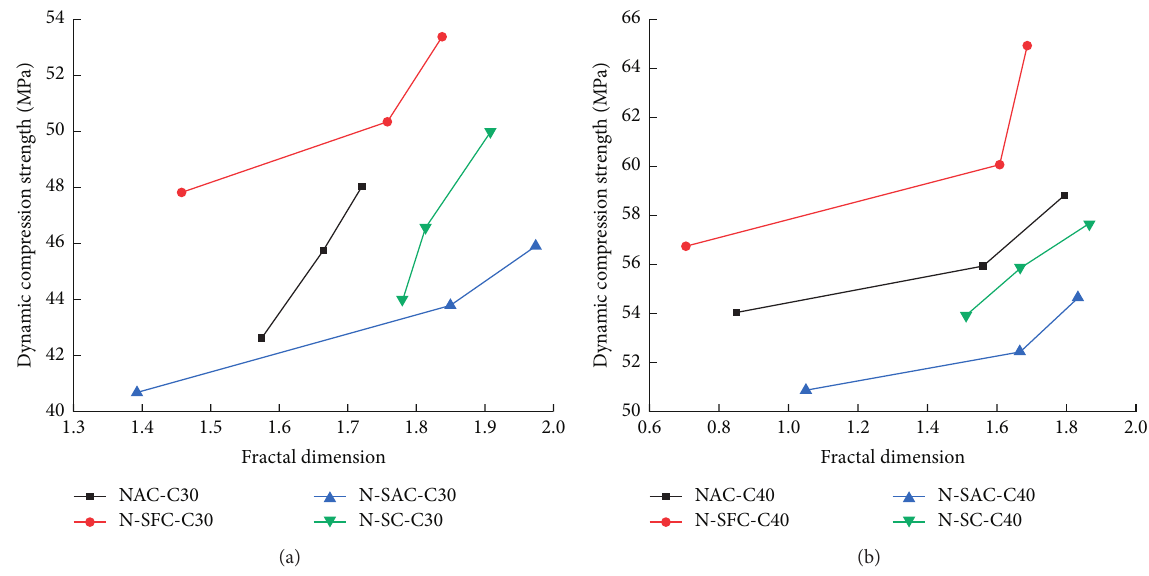
Figure 17: Relationship between fractal dimension and dynamic compressive strength index of concrete. (a) C30 groups. (b) C40 groups.